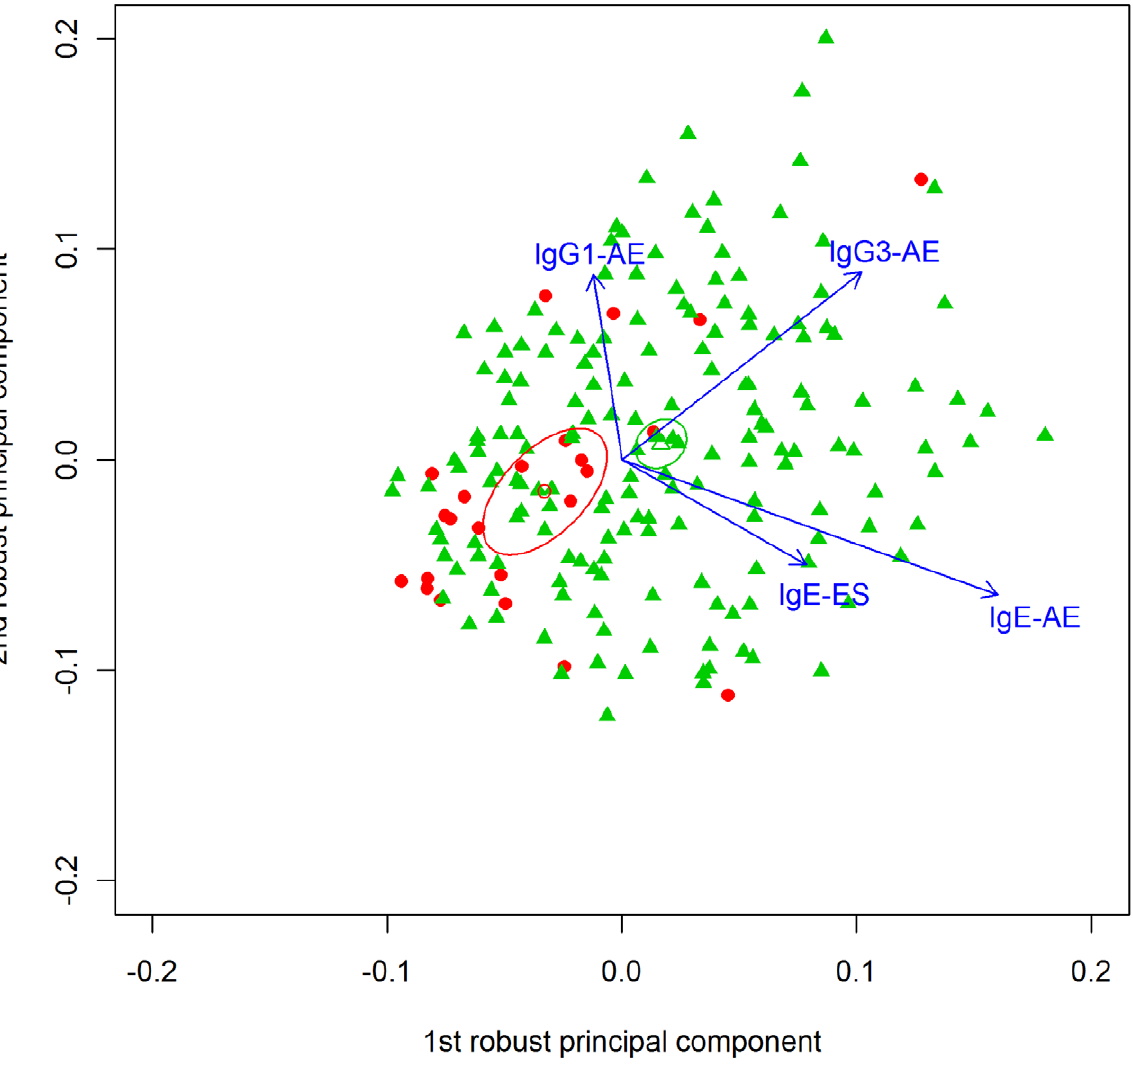
N Figure 2. Robust principal component analysis (PCA) of log-transformed serum antibody values in response to hookworm ) and co-infected ( m ) with hookworm are shown. The respective mean antigens. Footnotes: The principal component scores for individuals mono- ( values are shown as open symbols, with 95% confidence ellipses ( p value for bivariate T 2 test is 0.006). The arrows show the strongest loadings, i.e. contributions of the original variables to the principal components.